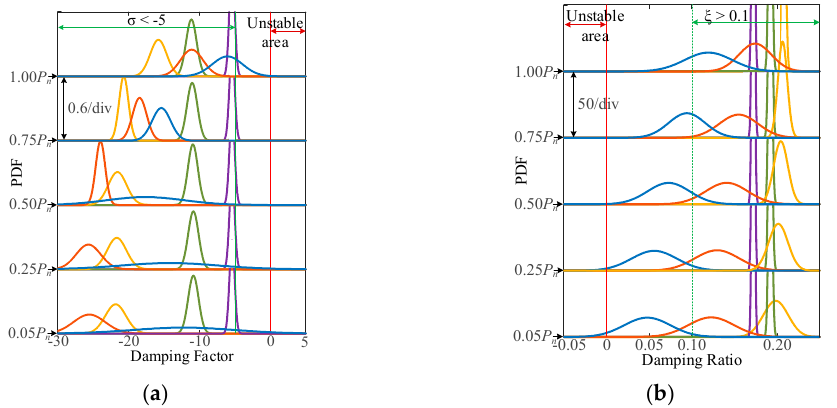
Figure 8. Probability density functions (PDFs) of stability indices for different grid SCRs and power levels. ( a ) PDFs of the maximum damping factor; ( b ) PDFs of the minimum damping ratio. Colors correspond to different grid SCRs in Figure 6a.